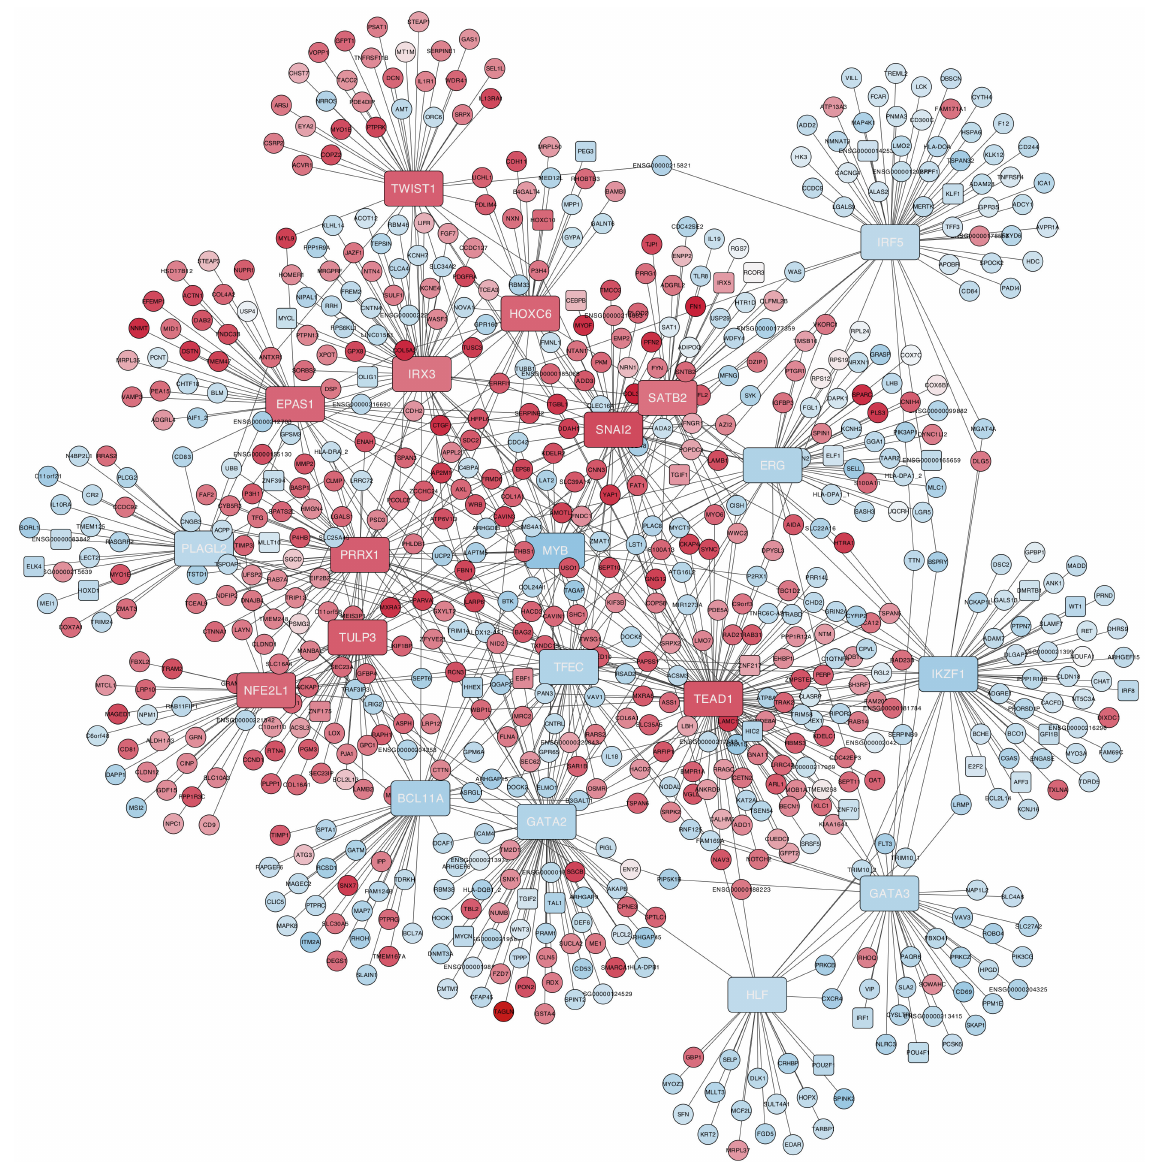
Figure 4. Gene co-regulation network presenting the top 10 up- and top 10 downregulated master regulators (in red and blue rectangles, respectively): The master regulators are connected with their regulons. Upregulated genes have a red background, while downregulated genes have a pale blue